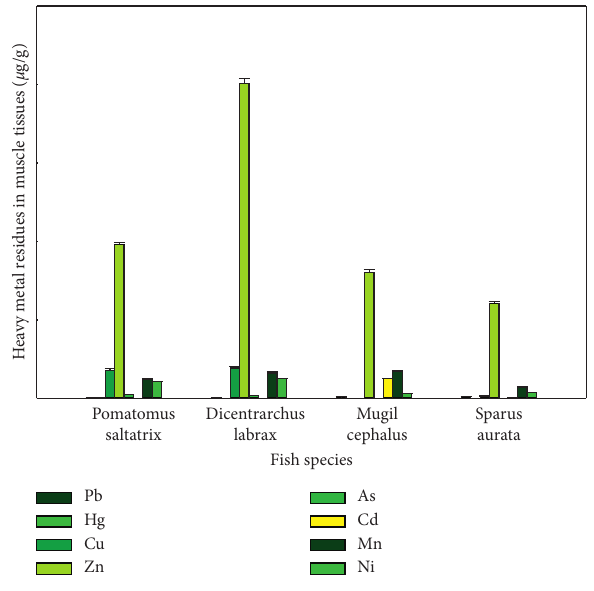
Figure 7: Concentration of Pb, Hg, Cu, Zn, As, Cd, Mn, and Ni residues ( μ g/g) in muscle tissues of fish samples from Bandırma Cost of Marmara Sea.